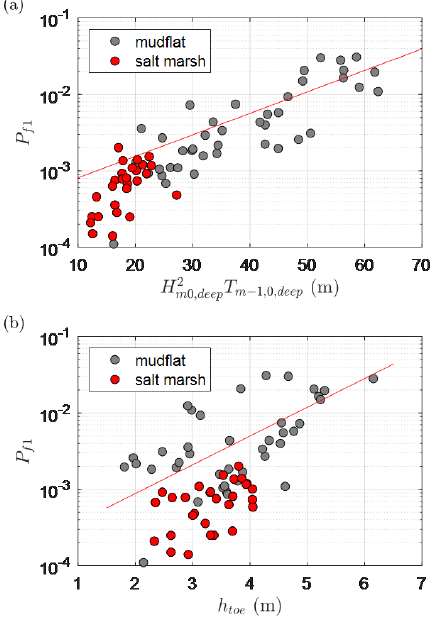
Figure 12. Relationship between the probability of failure for Sce- nario 1 (SS) and the following: (a) an offshore forcing parameter ) and (b) Sce- and (b) the water depth at the dike toe ( h toe ), across the wider Dutch 1 /P f ) across the Wadden Sea area. Lines indicate the best fit through the 2 1